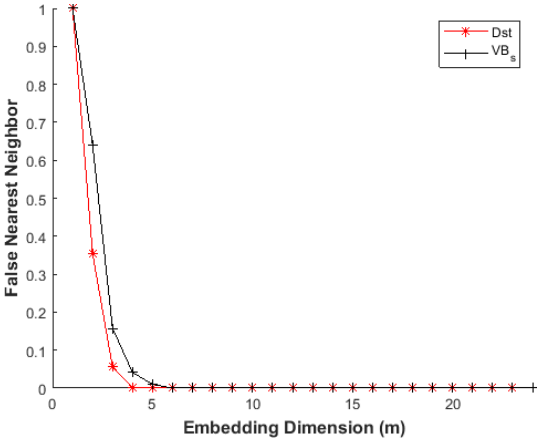
Figure 4. The plot of percentage of false nearest neighbours against embedding dimension ( m